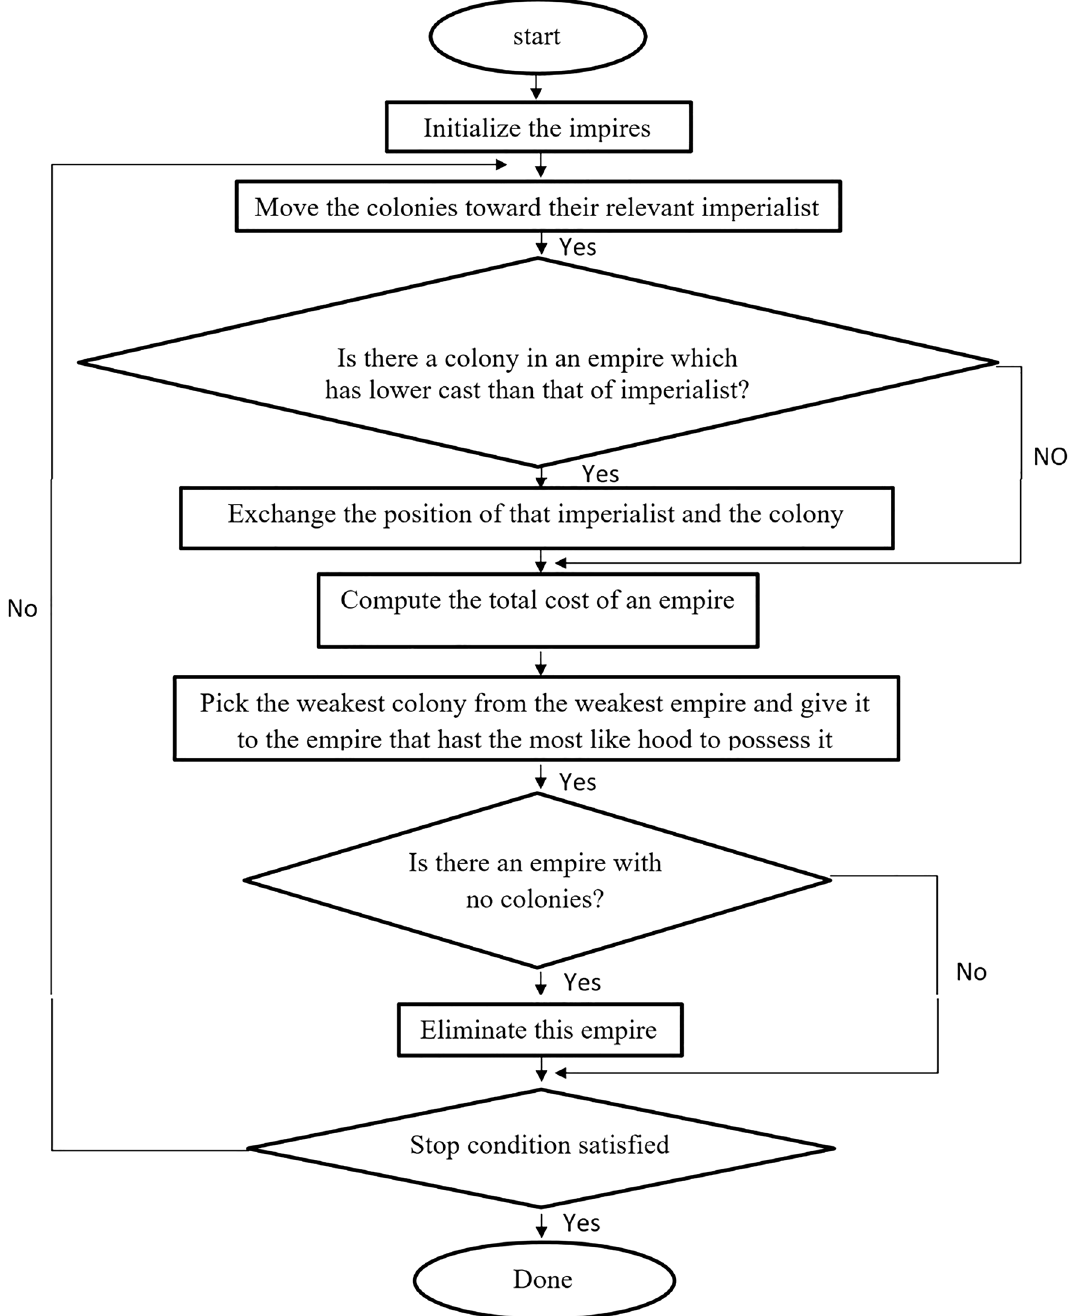
Fig. 5 Steps of the imperialist competitive shape (cylindrical or cubic), the traverse speed in three levels (27, 32 and 40 mm/min), the rotation speed in four levels (700, 850, 1000 and 1150 rpm), and also the pin’s angle in three levels (2°, 3° and 4°).